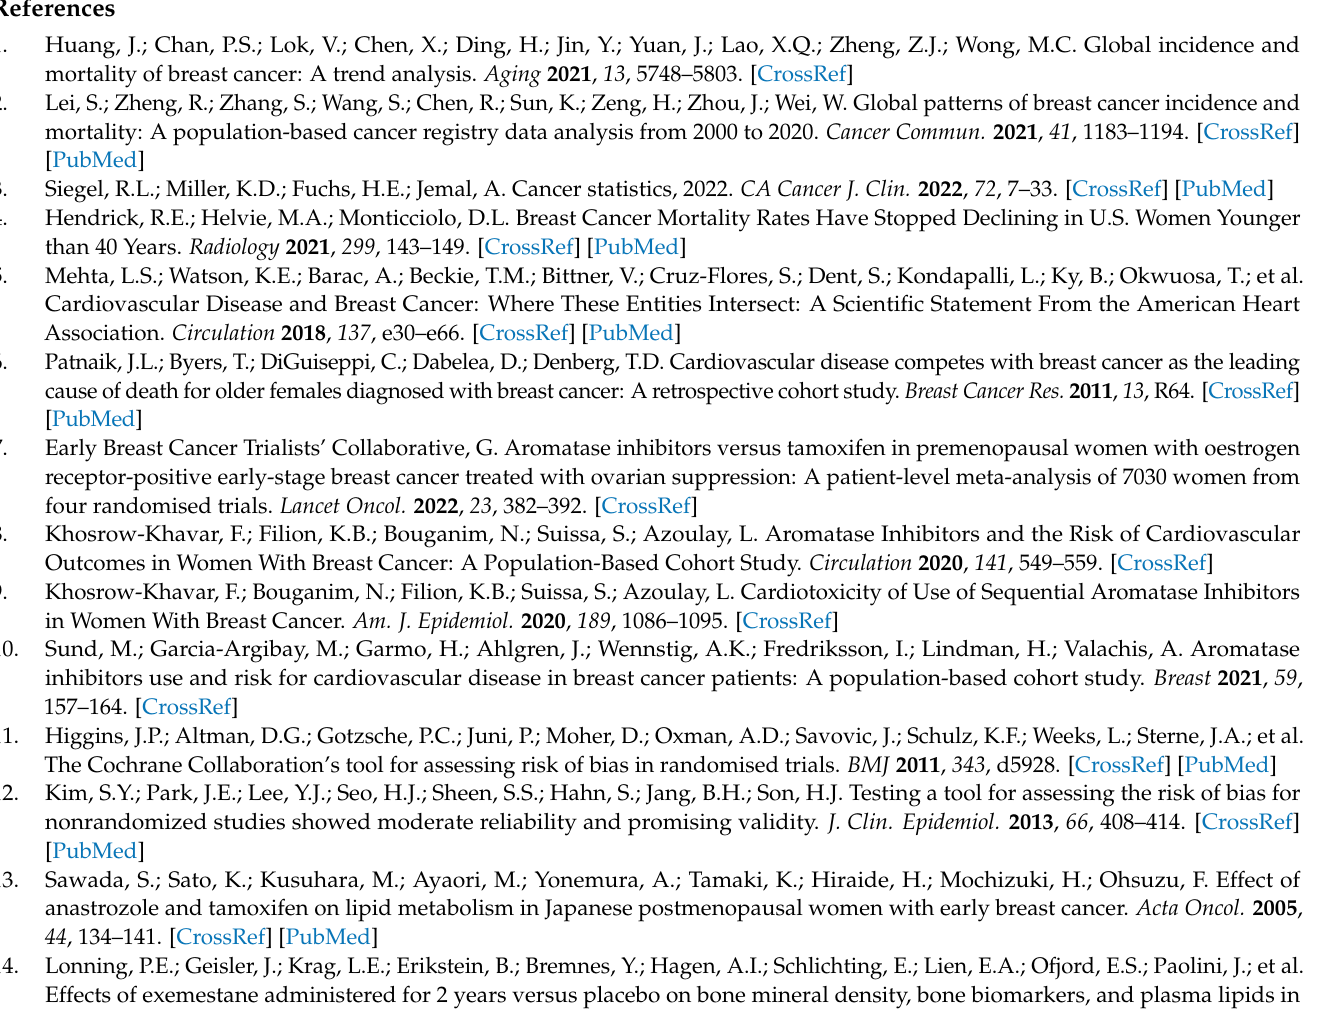
of Table 2; Figure S2: Forest plots and funnel plots of Table 3; Figure S3: Forest plots and funnel plots of Table